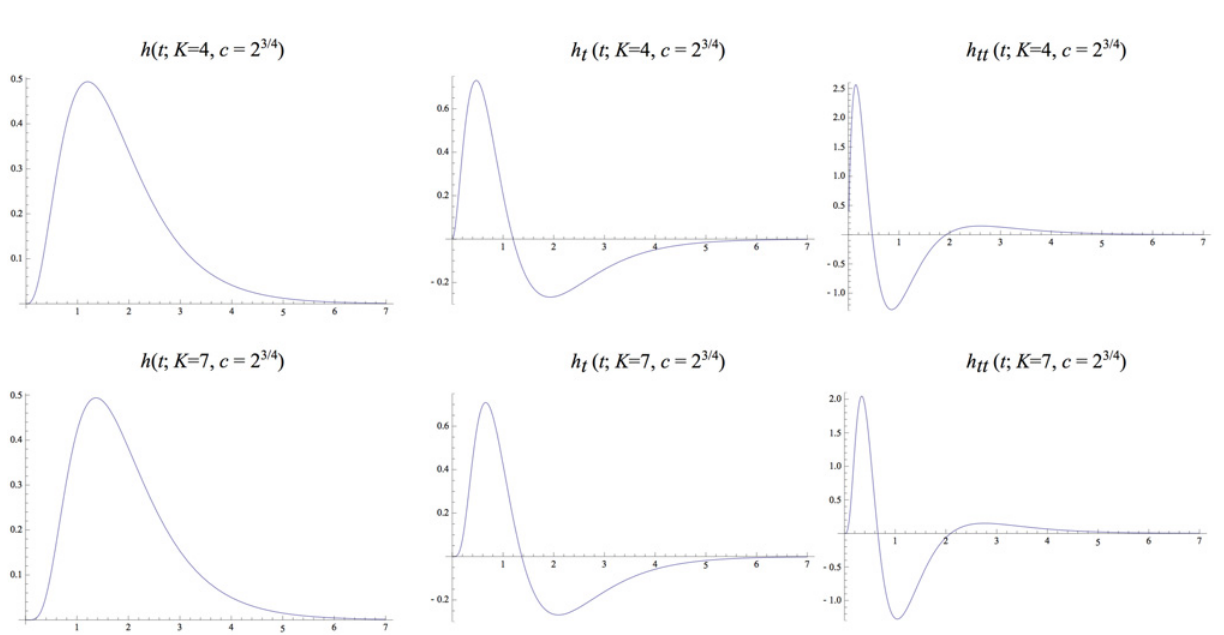
ð t ; m Þ ¼ (cid:3) K ð t ; m Þ with temporal variance τ = 1 corresponding to the composition of K = 4 or K = 7 truncated h Fig 6. Equivalent kernels h composed exp k k ¼ 1 exponential kernels with different time constants defined from a self-similar distribution of the temporal scale levels according to Equations (38), (39) and (40) and corresponding to a uniform distribution in terms of effective temporal scale τ eff = log τ for c = 2 3/4 and with their first- and second- order derivatives.